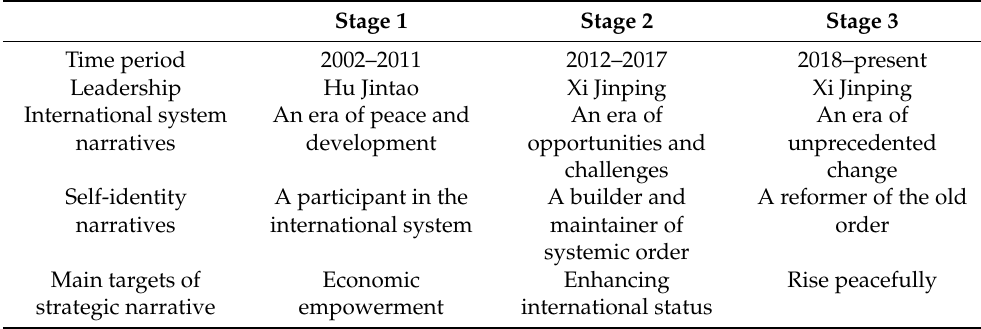
Table 1. The three stages of China’s ‘strategic opportunity period’ narrative